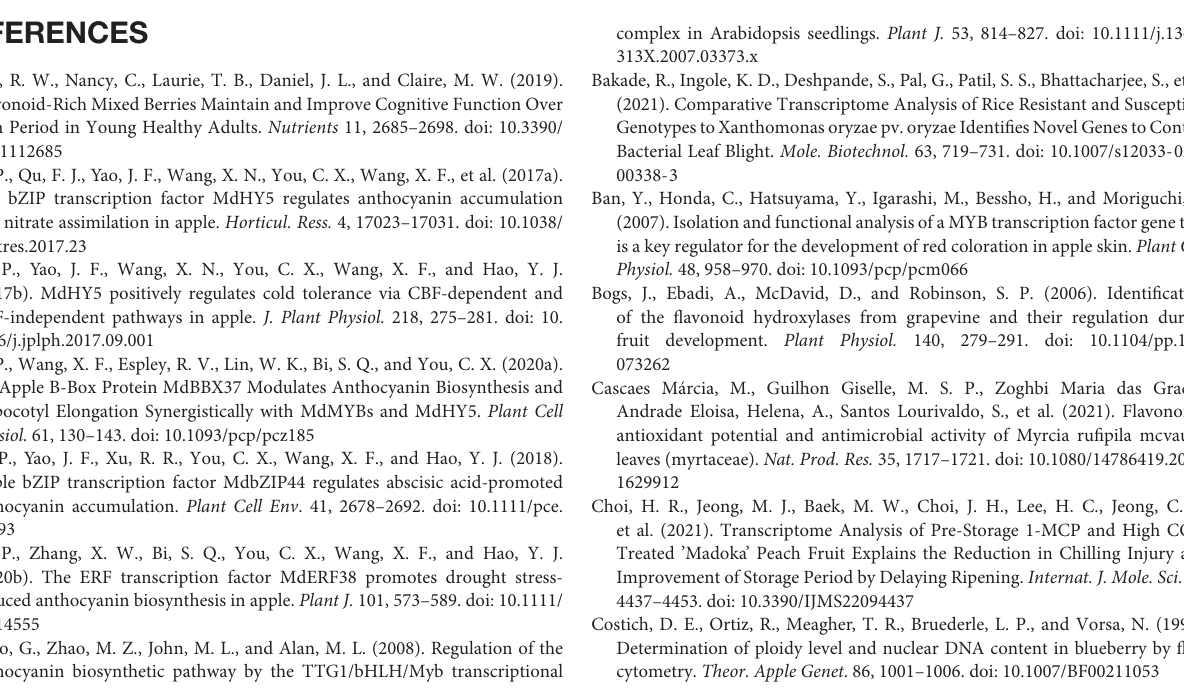
Supplementary Figure 1 | Venn diagram of long non-coding RNA (lncRNA) sequences predicted by three different methods. Supplementary Figure 2 | Schematic diagram of flavonoid synthesis in blueberries, including anthocyanin, proanthocyanidin, and flavonol synthesis. Supplementary Figure 3 | Transcript abundance of MYB genes at different developmental stages in blueberries. Supplementary Table 1 | Statistics of sequences length from Illumina and SMRT sequencing data.